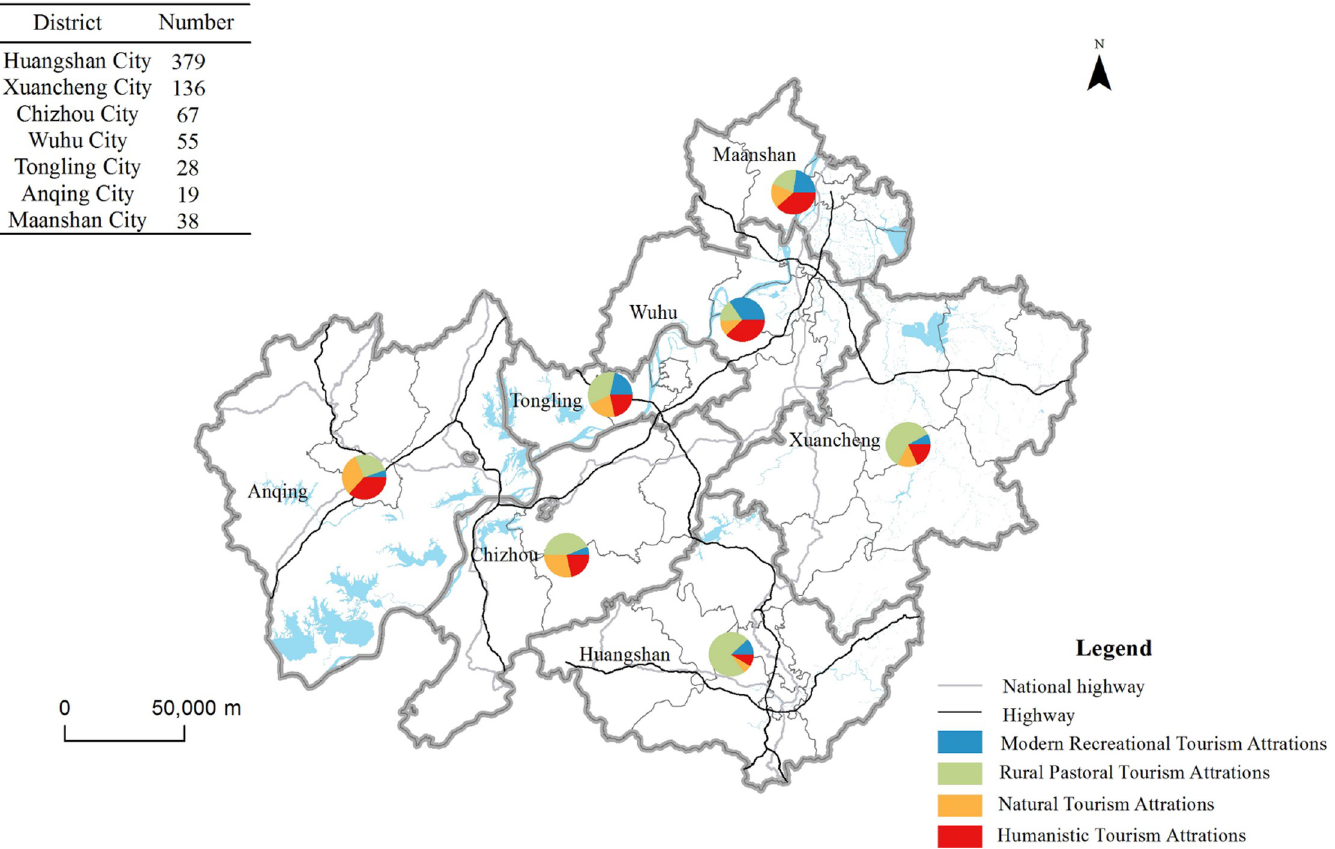
Fig 1. Regional distribution characteristics of tourist attractions in the demonstration region. Contains information from OpenStreetMap and OpenStreetMap Foundation, which is made available under the Open Database License.